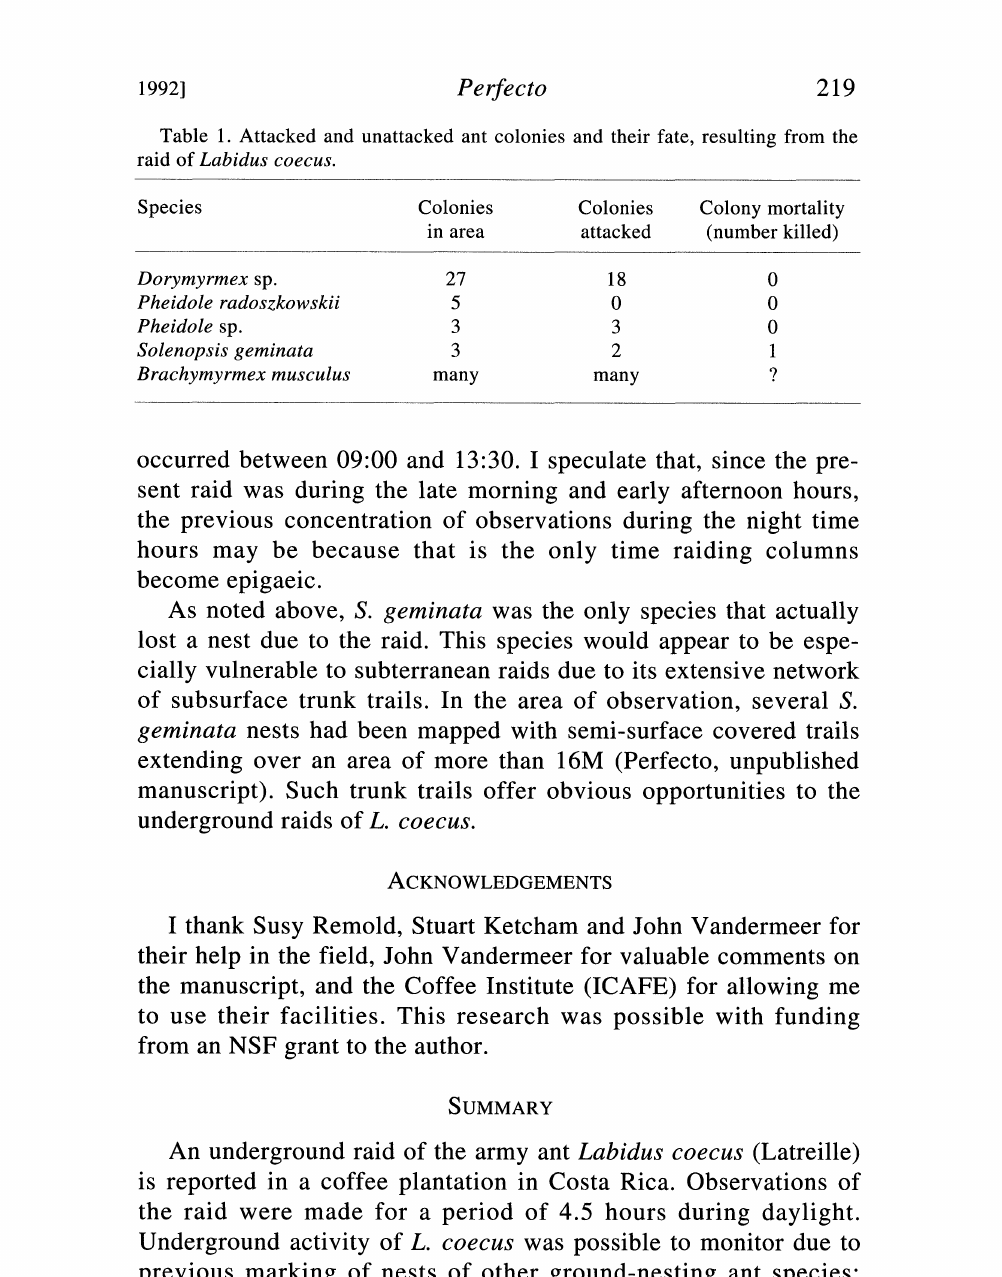
Table 1. Attacked and unattacked ant colonies and their fate, resulting from the raid of Labidus coecus. Species Colonies Colonies Colony mortality in area attacked (number killed) Dorymyrmex sp. 27